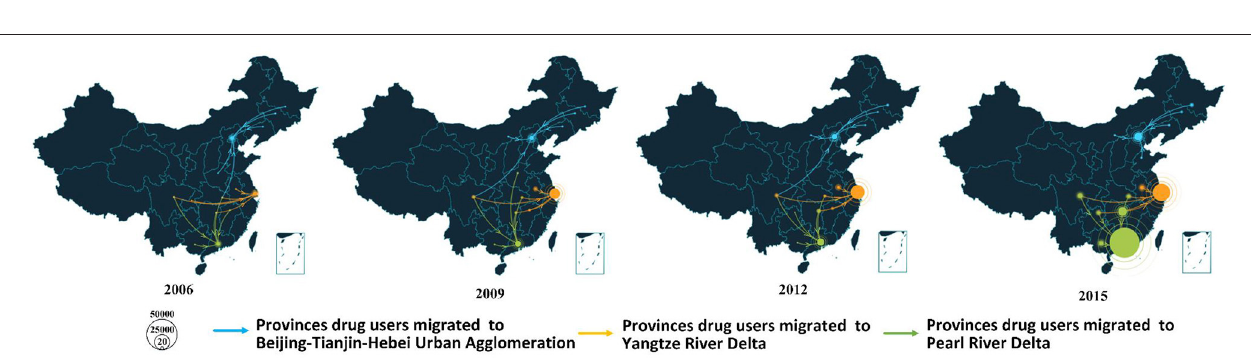
FIGURE 4 | The flow of methamphetamine use cases migrating to regions of Beijing-Tianjin-Hebei Urban Agglomeration, Yangtze River Delta, and Pearl River Delta (the arrow indicated the direction of migration among methamphetamine cases. The radius of the destination circle indicated the number of methamphetamine cases migrated into this region. The radius of the source circle indicated the number of methamphetamine cases migrated out this region).